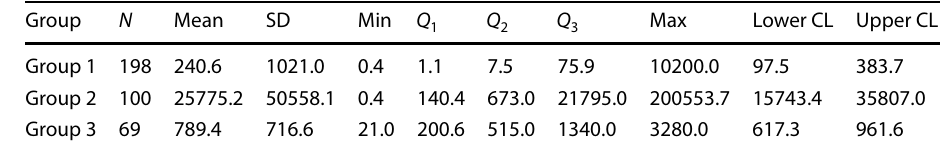
Table 3 The descriptive statistics of the removal of compounds for groups